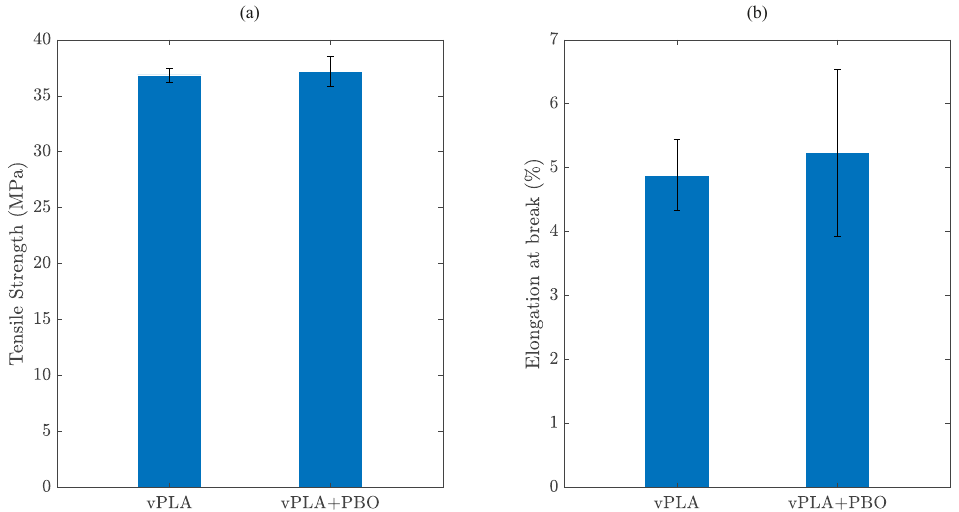
Figure 11. Tensile Strength ( a ) and Elongation at break ( b ) of the specimens produced through FFF technology with virgin PLA (vPLA) and virgin PLA mixed in the presence of PBO